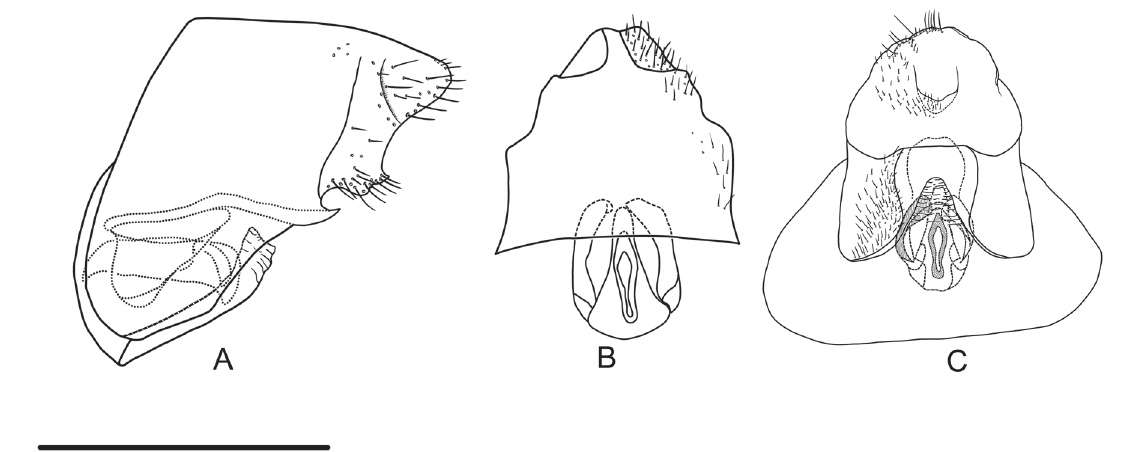
Fig. 7. Female genitalia of Apatidelia acuminata Leng & Yang, 1998. A . Lateral view. B . Dorsal view. C . Ventral view. Scale bar = 0.5